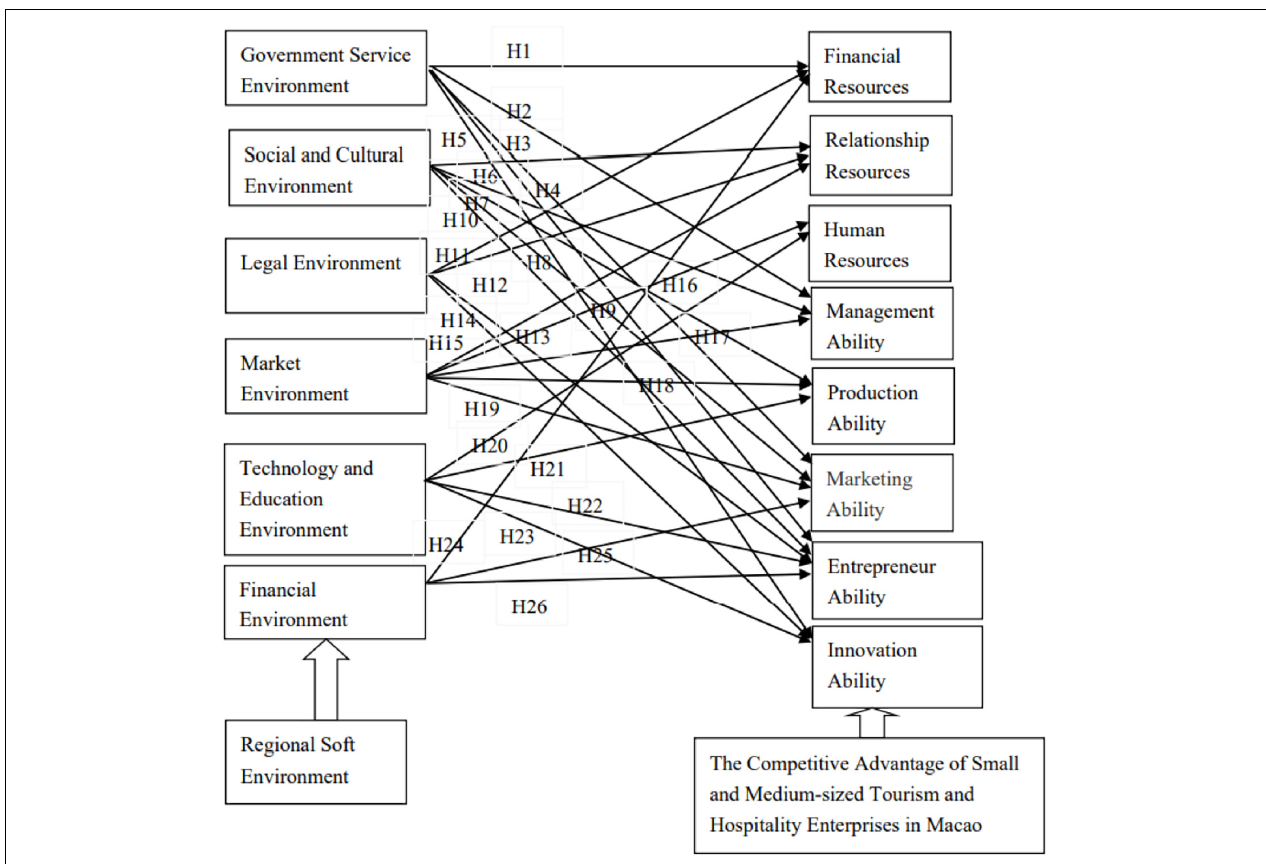
FIGURE 1 | Model of regional soft environment on SMEs in tourism and hospitality in